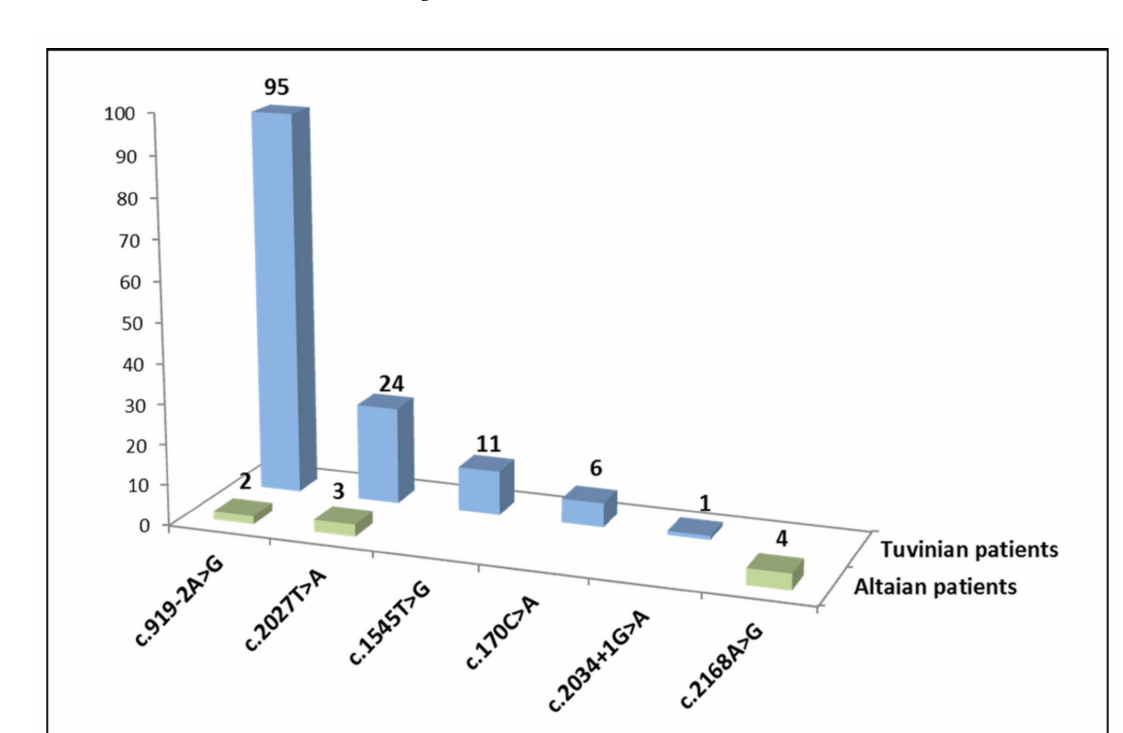
Figure 1. Distribution of pathogenic variants among all mutated SLC26A4 alleles in Tuvinian and Altaian